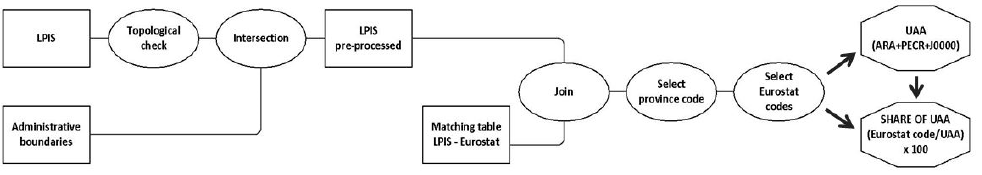
Figure 1. Workflow to compute the two context indicators. In the processing phase, the pre-processed LPIS was joined with the matching